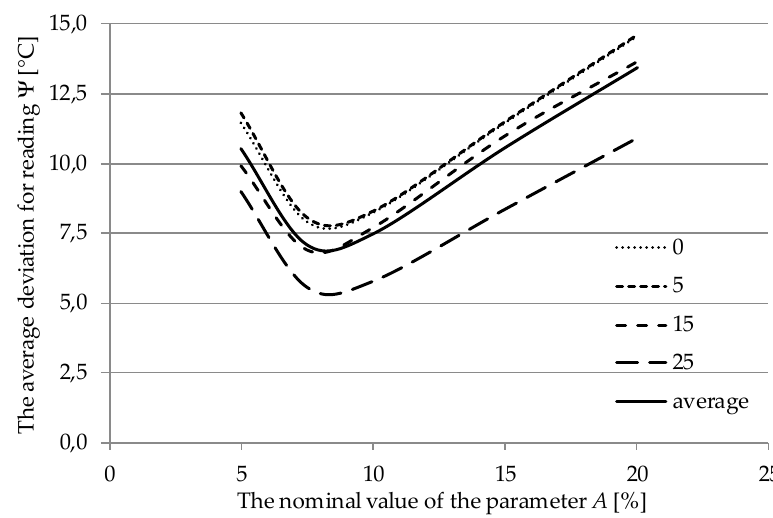
Figure 13. The mean absolute deviation Ψ between the measured and theoretical temperatures for HMA specimens depending on the value of A and ambient air temperature for the total test time.